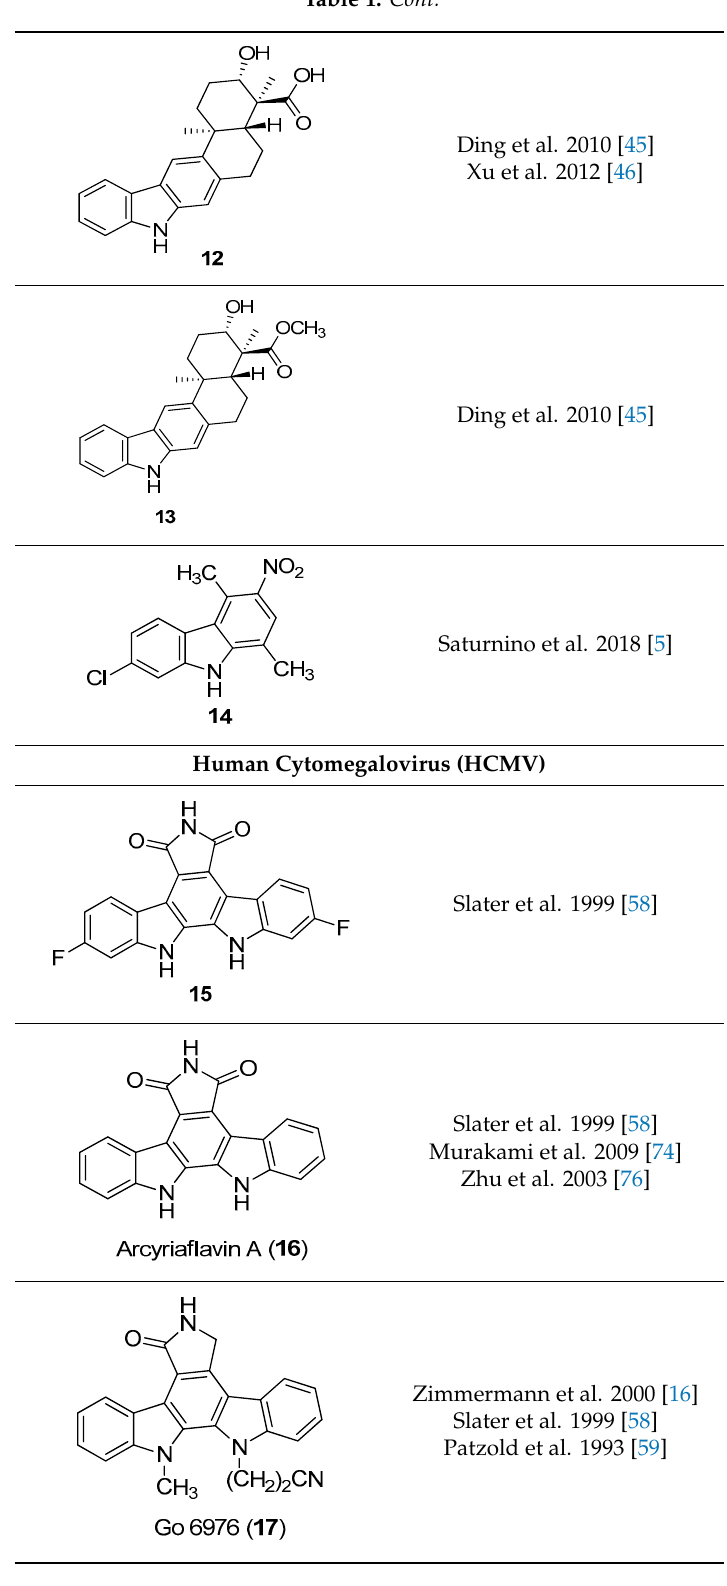
Molecules 2019 , 24 ,